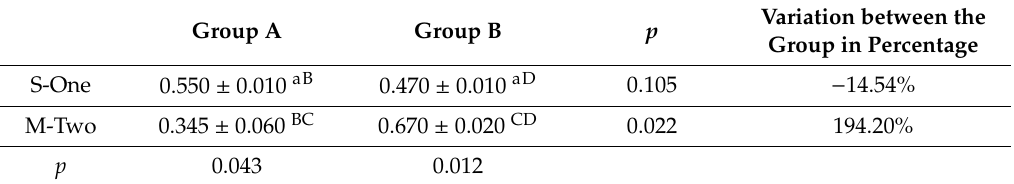
Table 1. Operative torque test (Ncm). p value was set a 0.05. Di ff erent capital superscript letters indicates significant di ff erence among the groups ( p < 0.05).